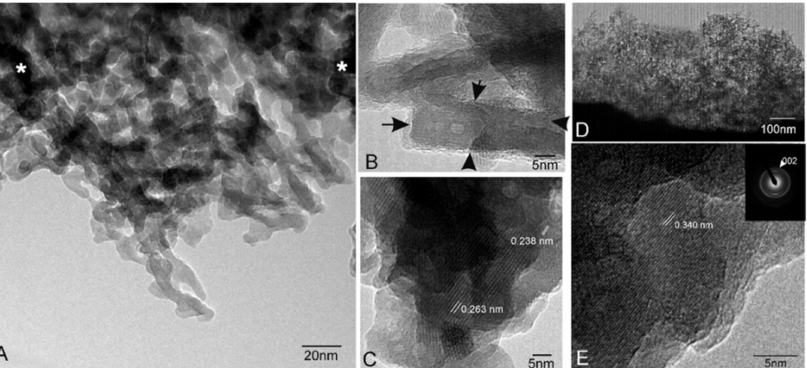
Figure 7. TEM images of the scaffold surfaces’ product: ( A ) after 7 days in culture (* dark regions from where the crystals grew), ( B ) zoom into the rectangular crystals, ( C ) the HRTEM image of the region, ( D ) after 28 days in culture showing the morphology of the new precipitate Ca-P phase and ( E ) the HRTEM of the region with a SAD